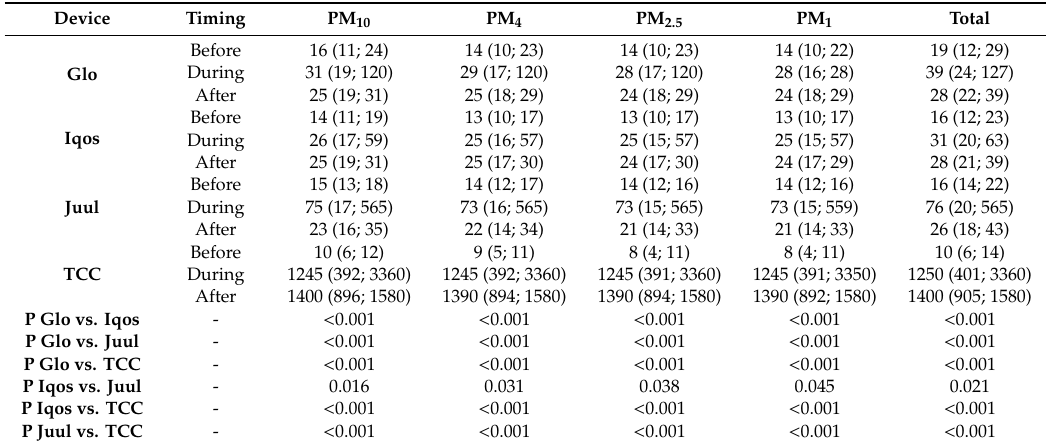
Table1. Levelsofparticulatematter(PM),expressedas µ g / m 3 , comparingGlo, Iqos, Juul, andtraditional combustion cigarettes (TCC) *.